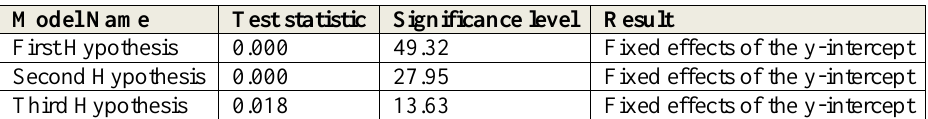
Table 8. Hausman test results